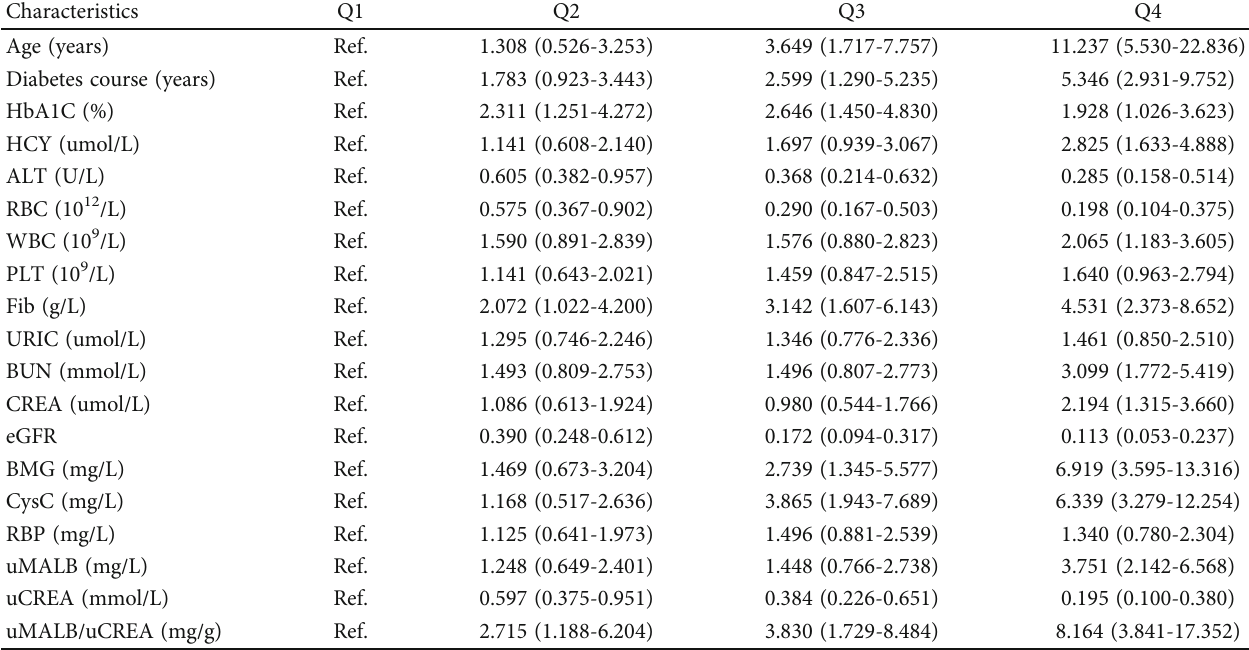
Table 2: Univariate logistic regression analysis between risk factors and